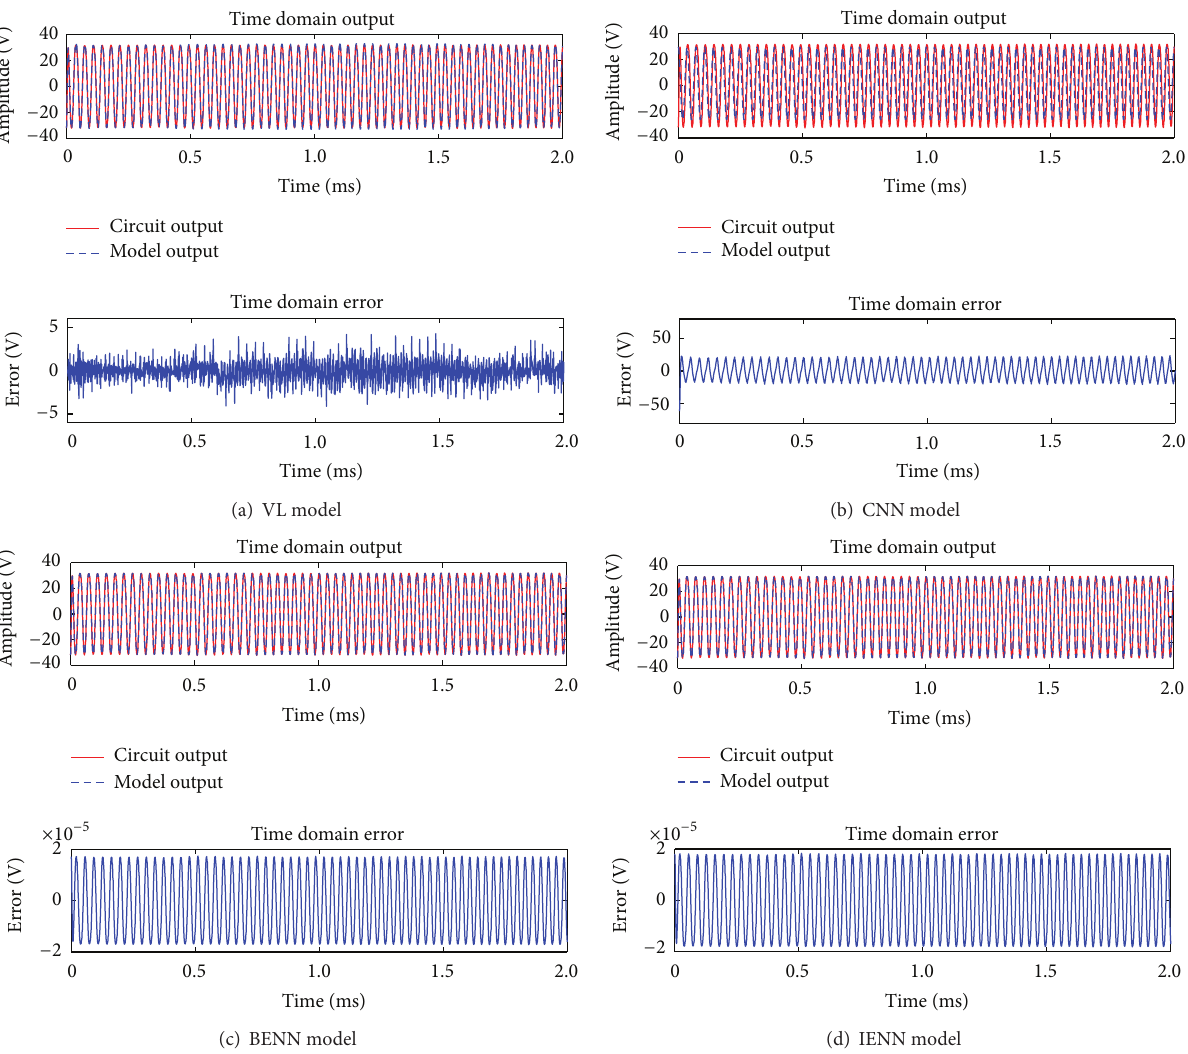
Figure 7: Comparison among four behavioral models in time domain with LFM signal